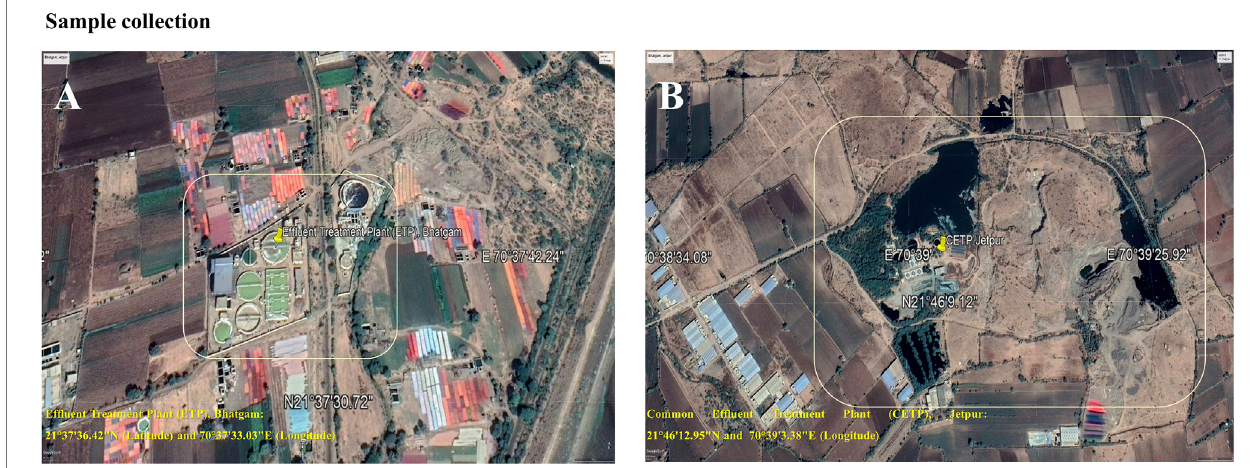
FIGURE1| Wastewater ef fl uentsampleswerecollectedfromtheJetpurtextileindustryclusterfromGujarat,India, whichisamajorhuboftextile-based industries. Thesamplingsitesincludedwereef fl uenttreatmentplant(ETP,1) (A) andcommonef fl uenttreatmentplant(CETP,1) (B) ,wherethe fi naldischargesamplesweretreated in the lagoon by the phytoremediation process with the nearby plant species and wash area from the dyeing and print house. The reddish/orange color indicates the washing area around the ef fl uent treatment plant.